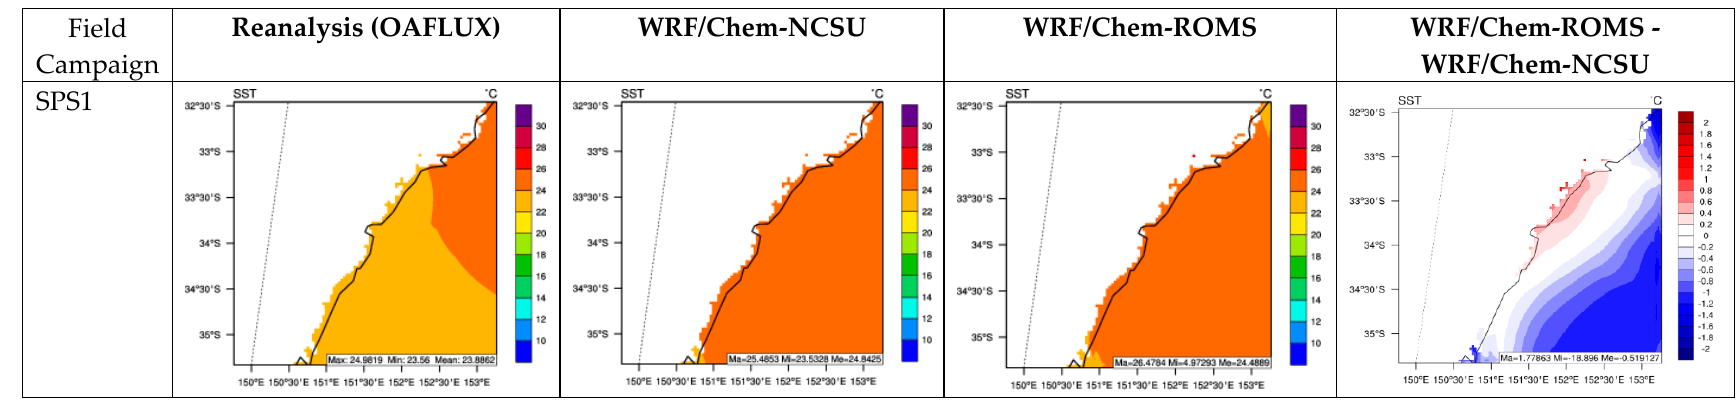
Figure 1. Observed and simulated SST over southeastern Australia (d02). Two sets of simulation results at 3 km are compared, one from WRF/Chem-NCSU and one from WRF/Chem-ROMS.